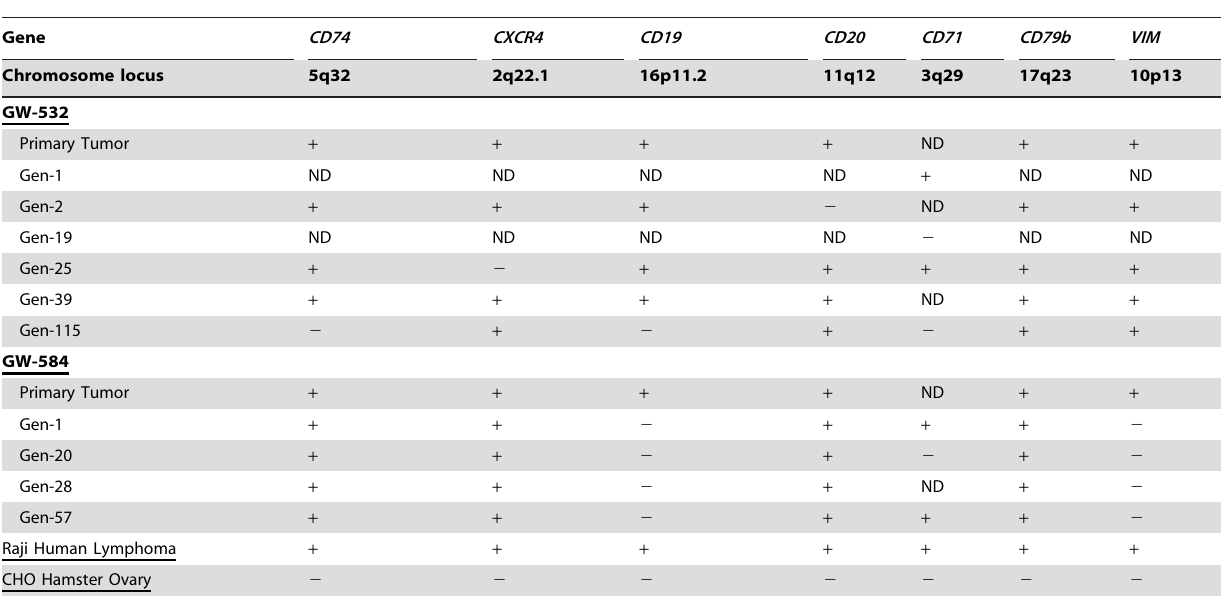
Table 1. PCR detection of human genes in malignant hybrid xenografts and control